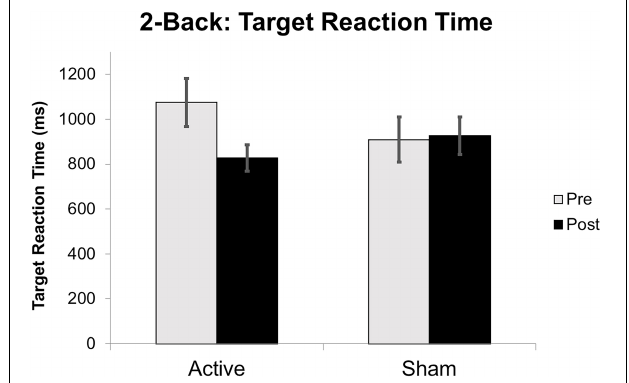
FIGURE 7 | Reaction time on 2-Back target stimuli reported in milliseconds (ms) from baseline to post-intervention. Error bars represent standard error of the mean.